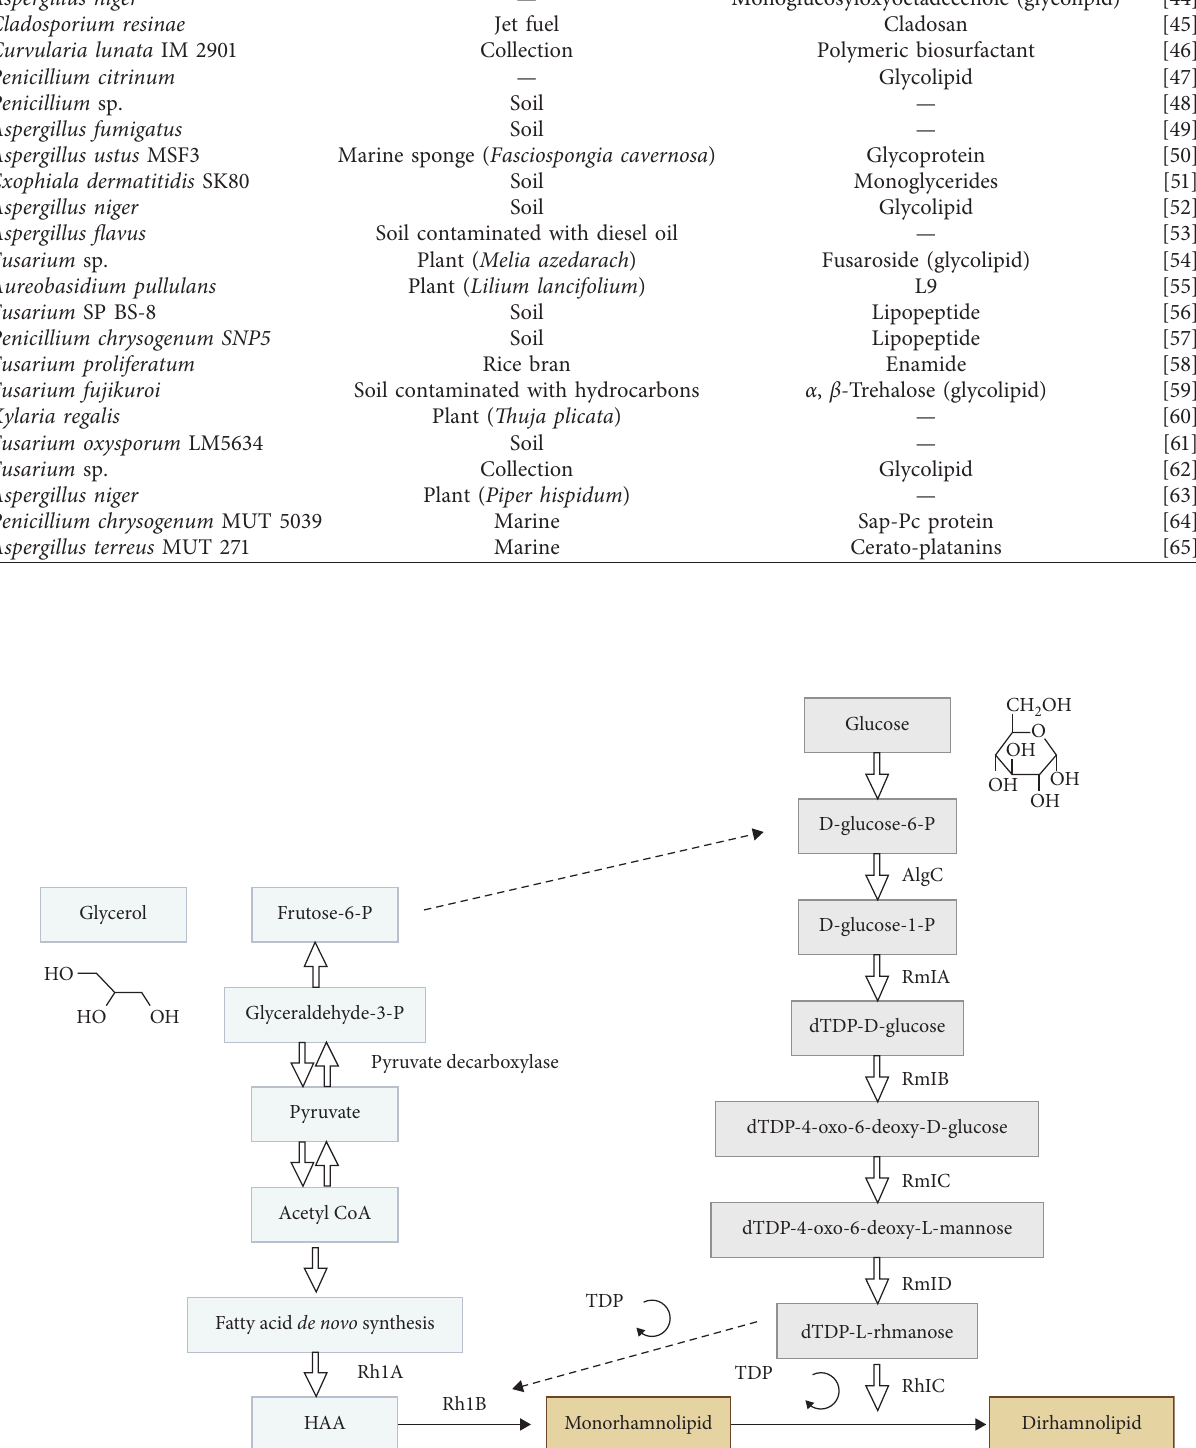
Table 1: Several classes of biosurfactants produced by fungi isolated from different environmental sources.